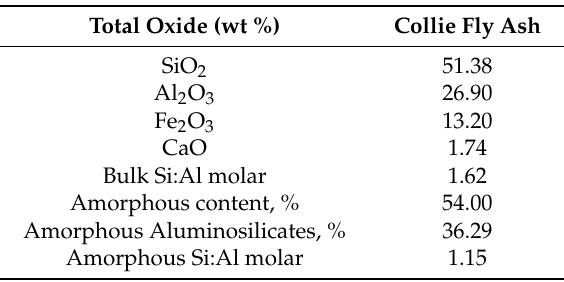
Table 1. Differences in bulk and amorphous Si:Al for Collie fly